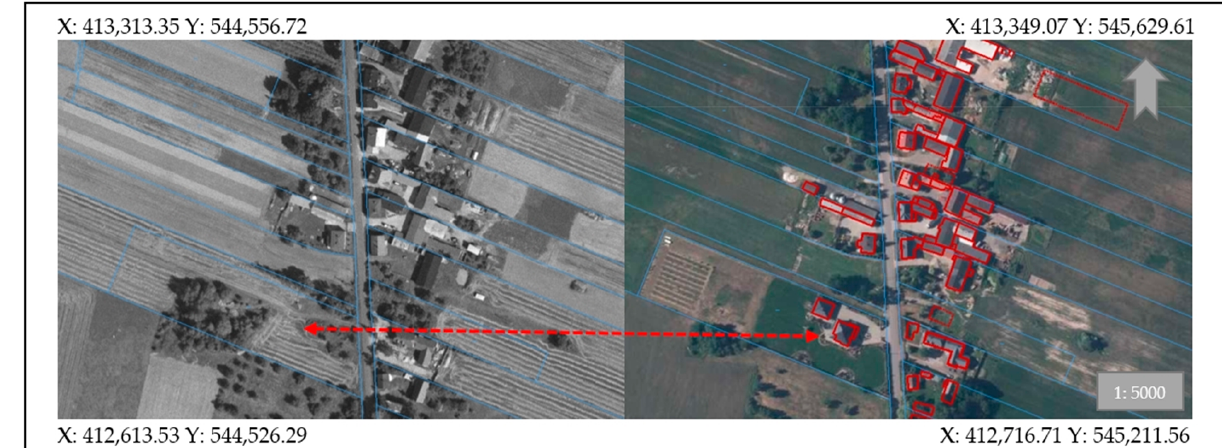
Figure 7. Changes of the land use types over time from agricultural land (2010— left ) to residential land (2020— right ). X, Y—coordinates of the corners of the image. Source: own study [40].